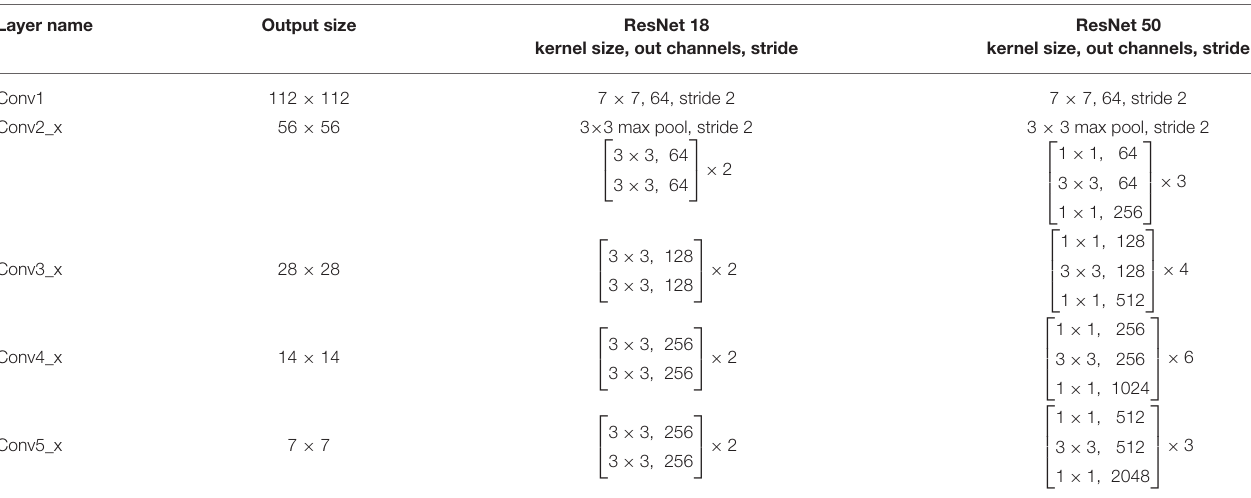
TABLE 2 | ReNet18 residual block